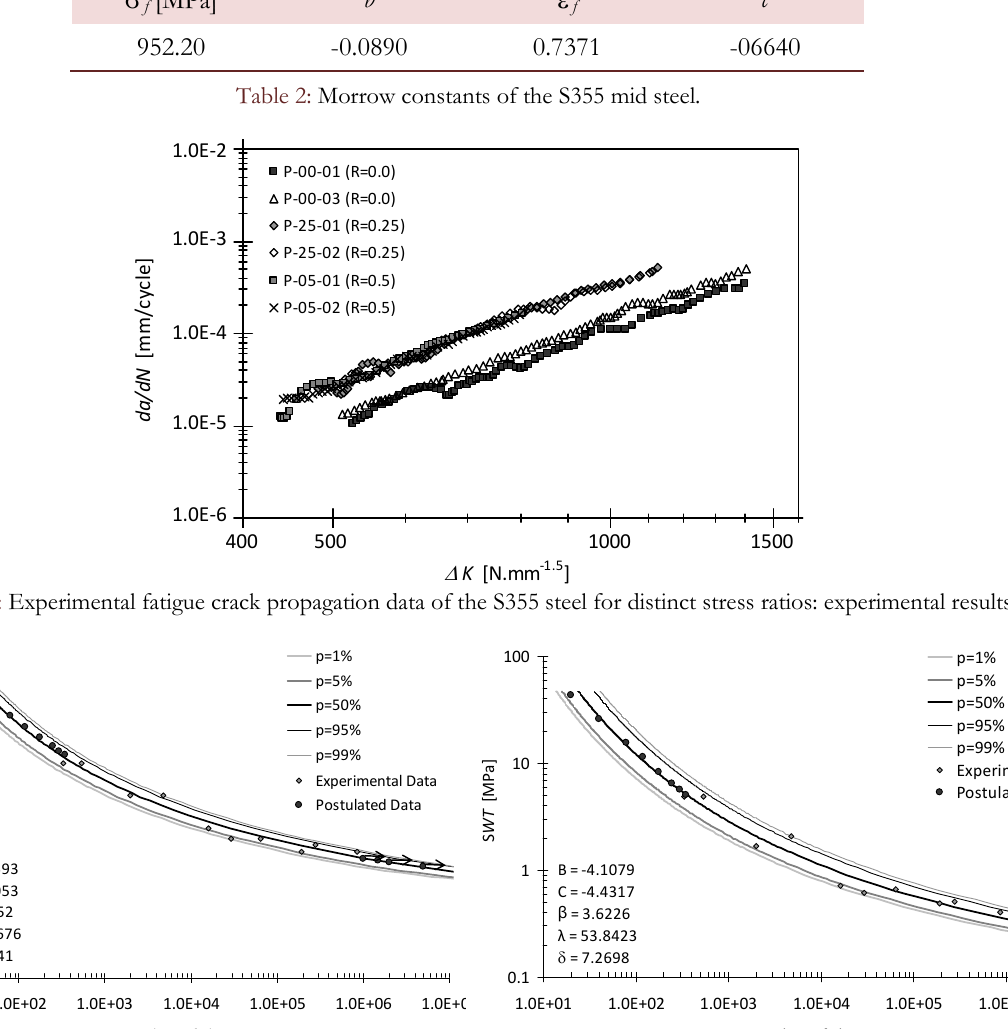
Figure 6: p- ε -N field for the S355 steel. Figure 7: p-SWT-N field for the S355